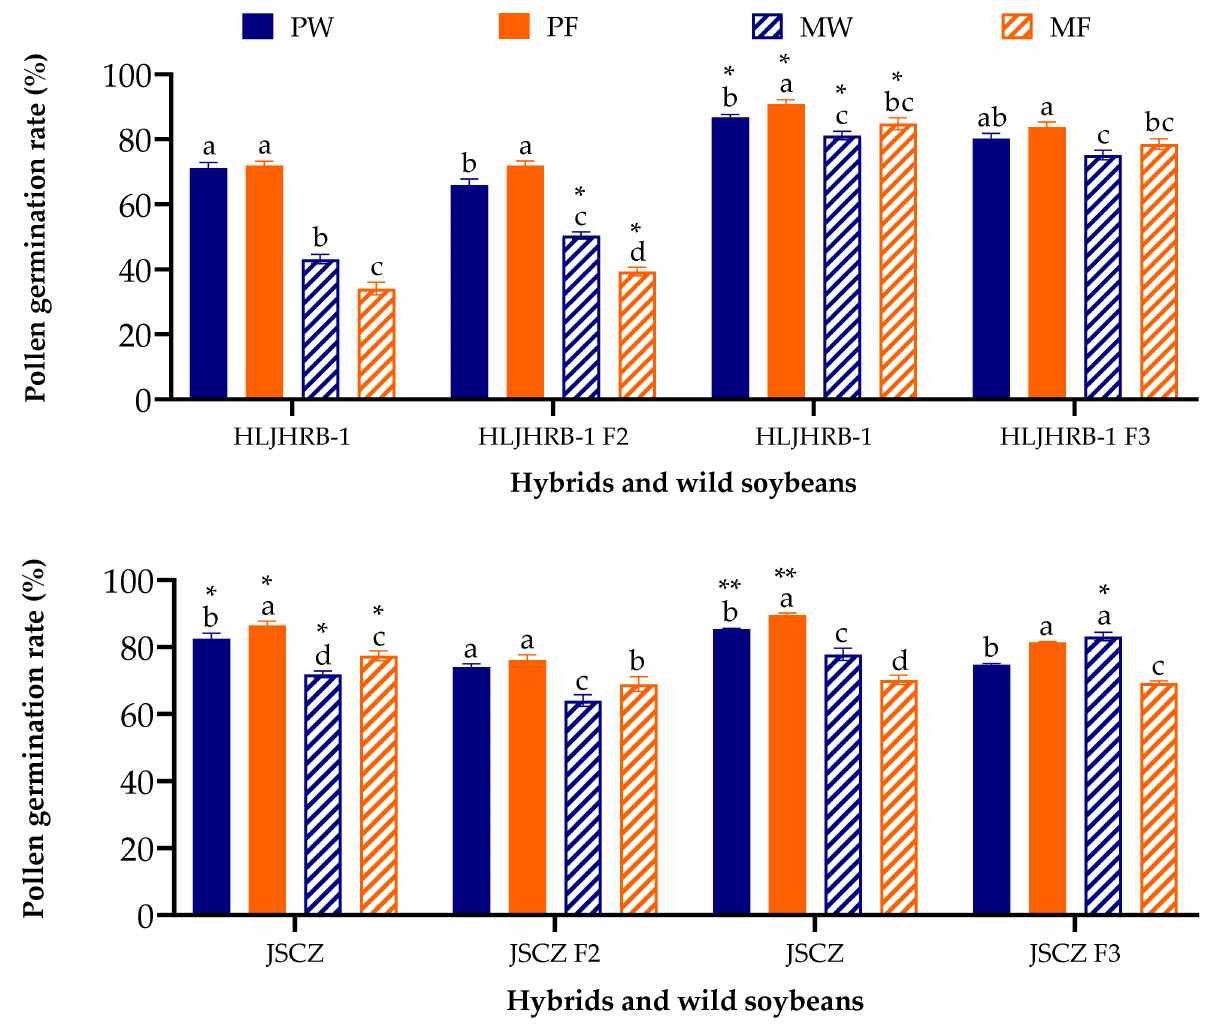
Figure 5. Vitro pollen germination rate of hybrids and wild soybeans at 60 min under four planting conditions. Note: * and ** indicate significant difference ( p < 0.05) and extremely significant difference ( p < 0.01) of the same trait between hybrids and their wild soybeans. Different lowercase letters indicate significant difference ( p < 0.05) of hybrids or wild soybeans among four planting